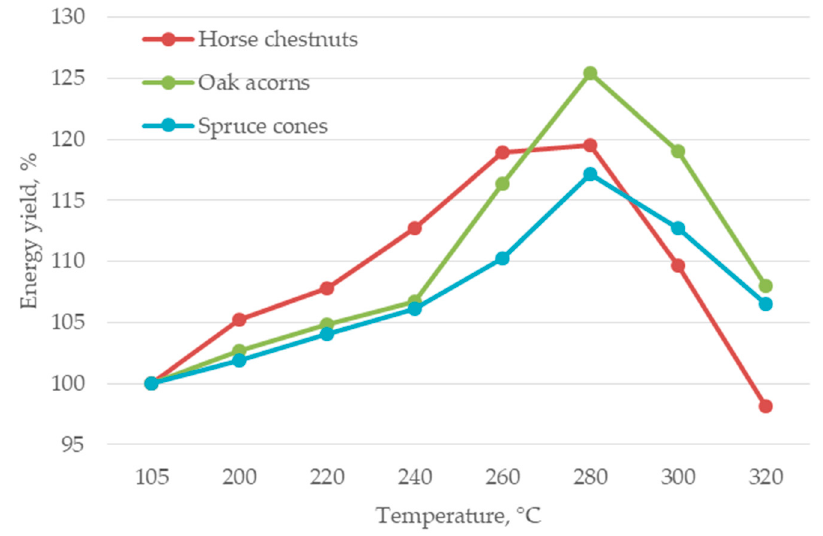
Figure 16. Energy yield of the torrefied forestry biomass.